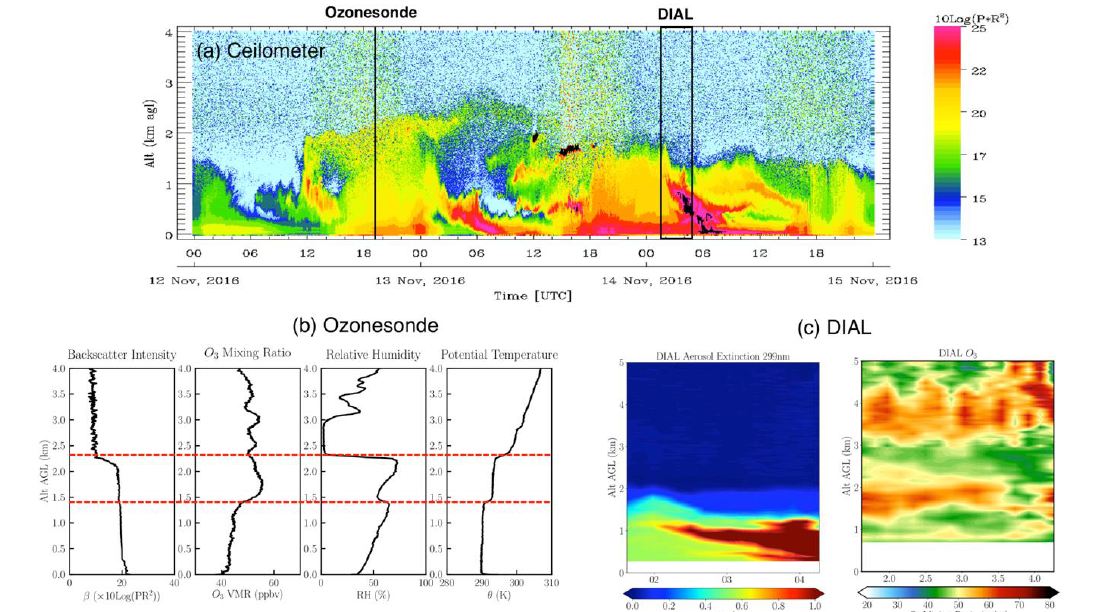
Figure 1. (a) UAH MIPS CT25K ceilometer backscatter intensity time-height curtain in Nov 12-14 (By courtesy of Kevin Knupp). (b ) Ceilometer backscatter intensity (β), ozonesonde (Flight number: HU995) ozone volume mixing ratio (O 3 VMR), relative humidity (RH), and potential temperature (θ) on Nov 12 19UTC are displayed, respectively. Two red dashed lines indicate two inversion layers. (c) DIAL aerosol extinction coefficient at 299nm and aerosol-correction O 3 on Nov 14